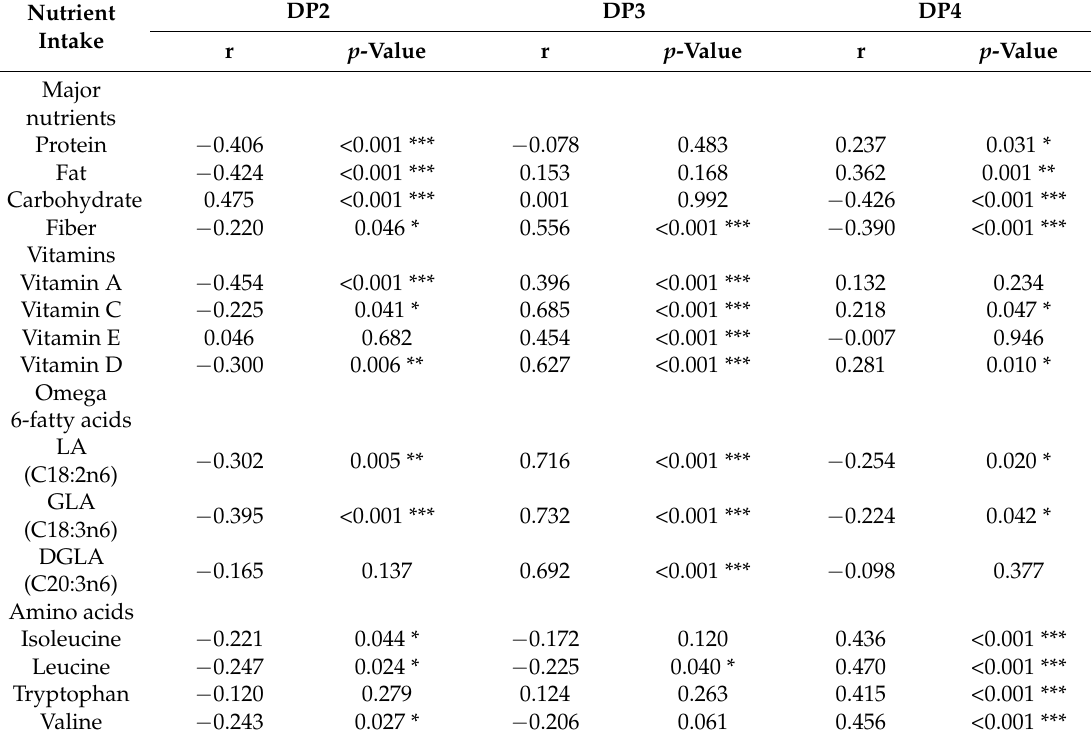
Table 5. Correlation between nutrient intake and dietary pattern scores